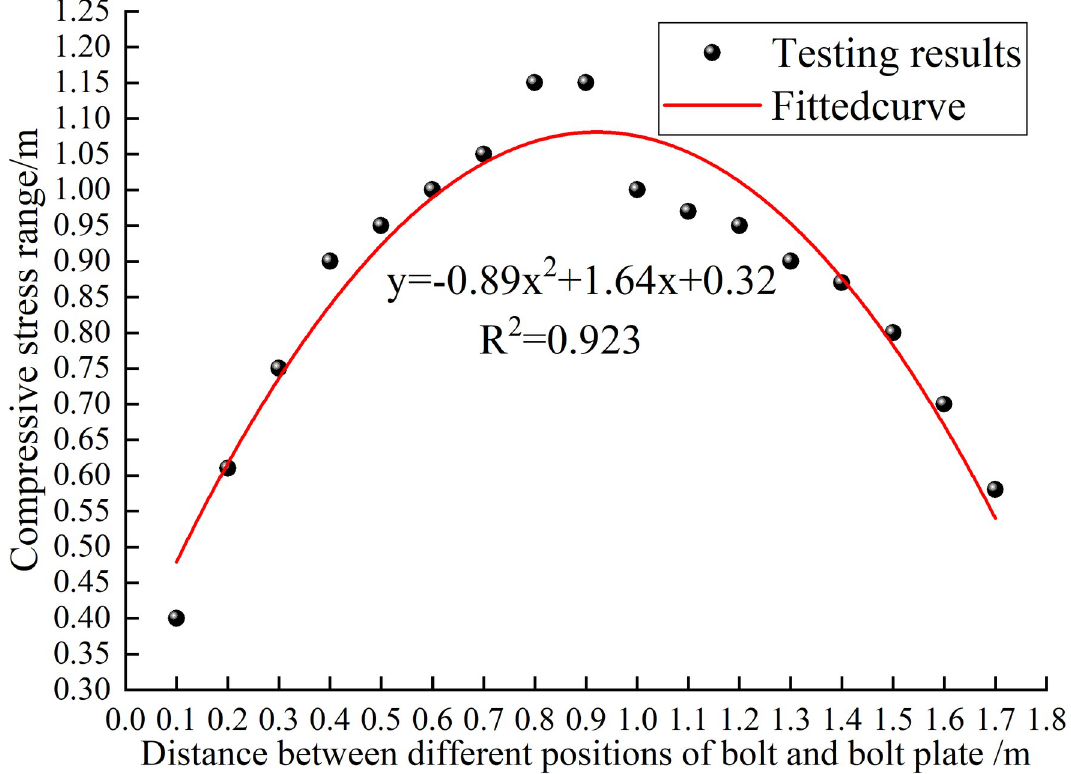
Fig 10. Curves of compressive stress range of different